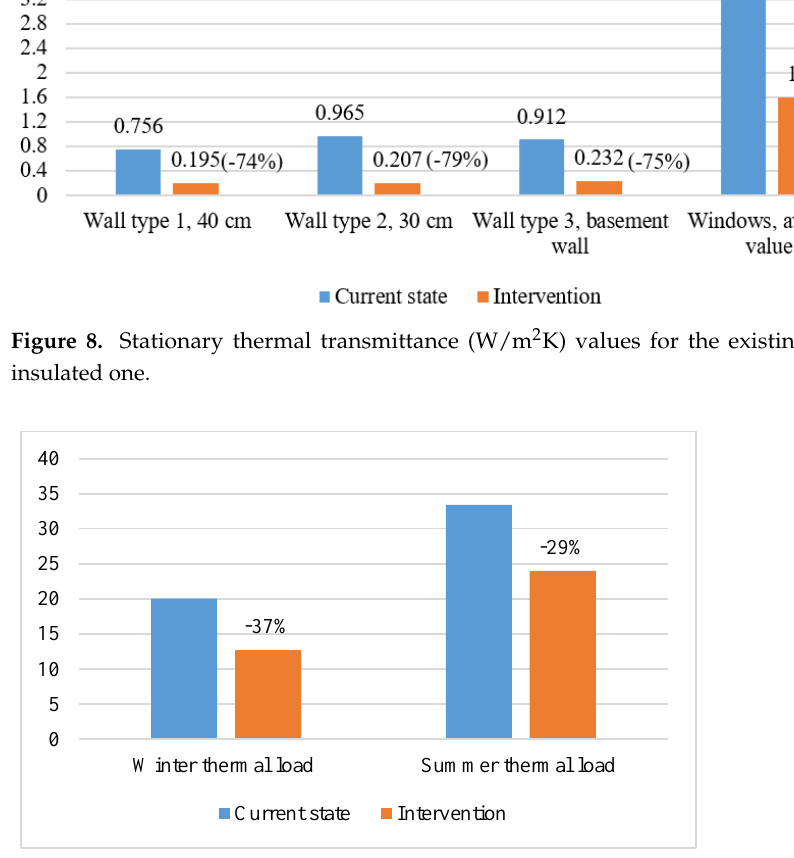
Table 6. Energy comparison between the current state and the three proposed scenarios.